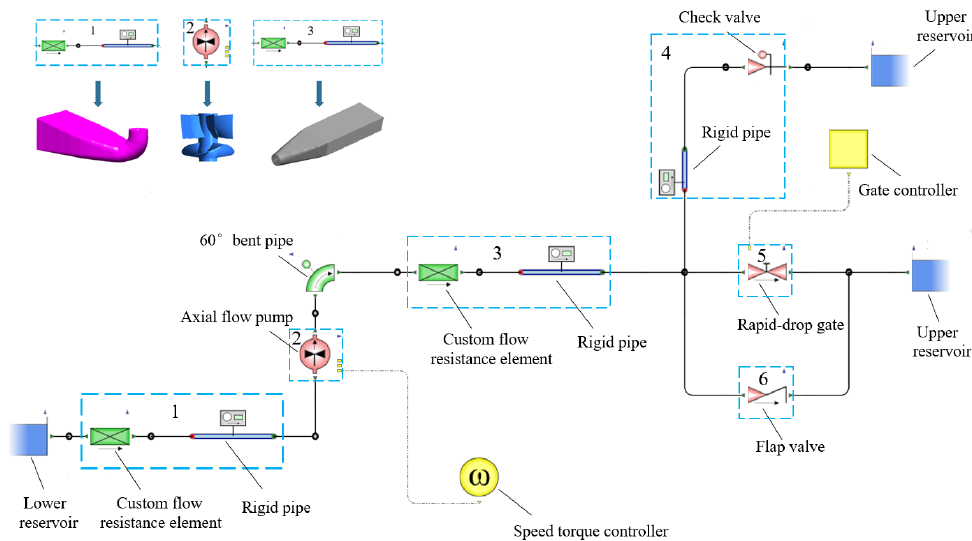
Figure 3. Schematic diagram of the LAPS simulation model.